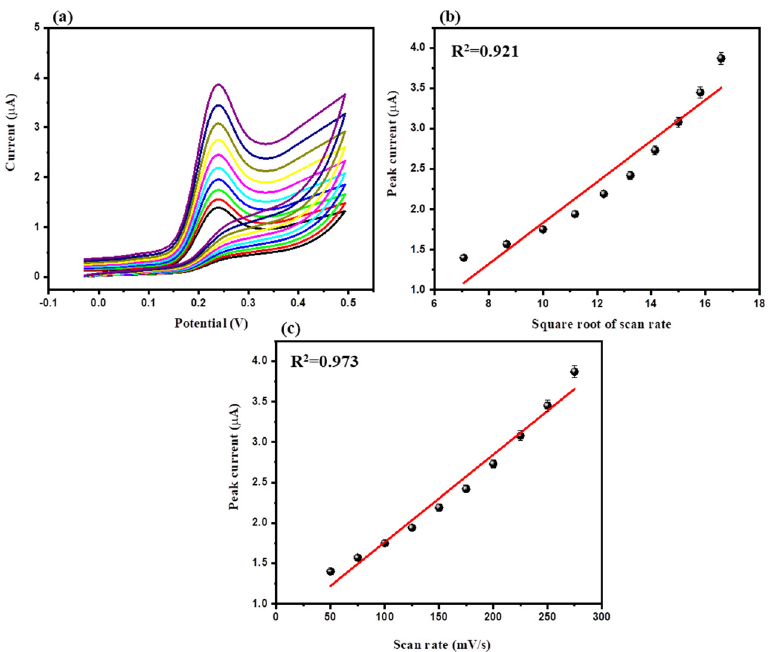
Figure 6. CVs ( a ) of MGCE in 2 µ M serotonin in 0.1 M PBS (pH = 7.0) at various scan rates (50, 75, 100, 125, 150, 175, 200, 225, 250, and 275 mV/s). Calibration curve between peak current response versus square root of scan rate ( b ). Calibration curve between peak current response versus scan rate ( c ).